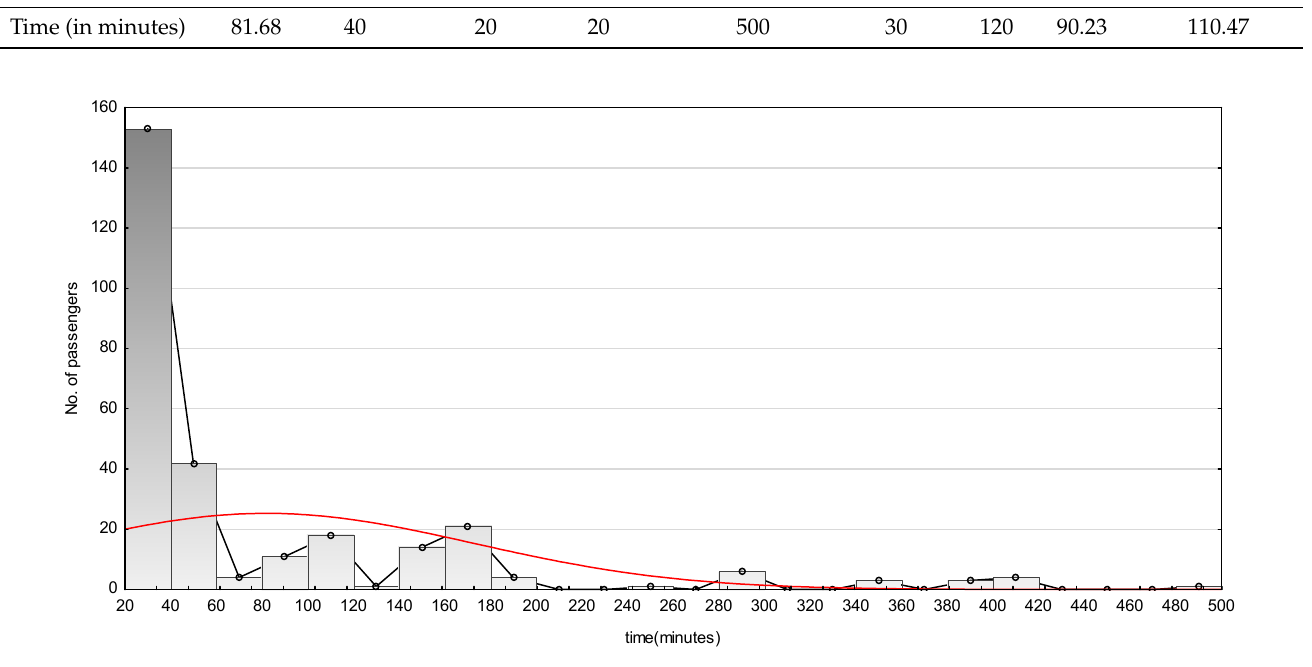
Figure 2. Distribution of observation for the time of travel. Explanation: red line represents normal distribution of data.